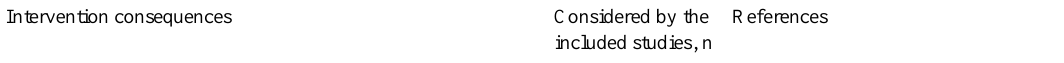
Table 2. Intervention consequences—resource usage. nIntervention consequences eHealth usage by